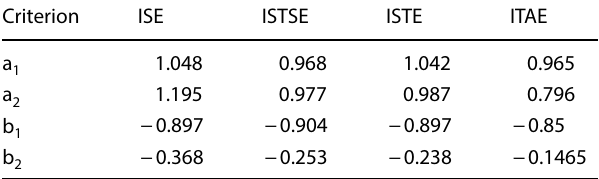
Fig. 10 Open-loop response curve